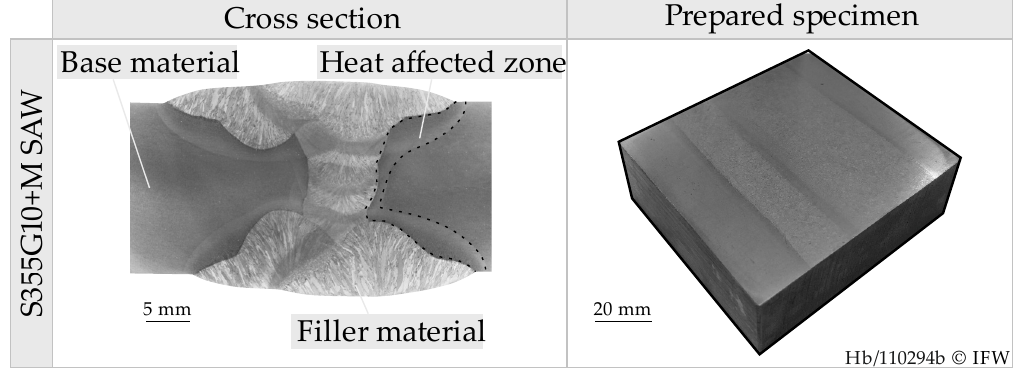
Figure 1. Cross-section of weld and specimen geometry .